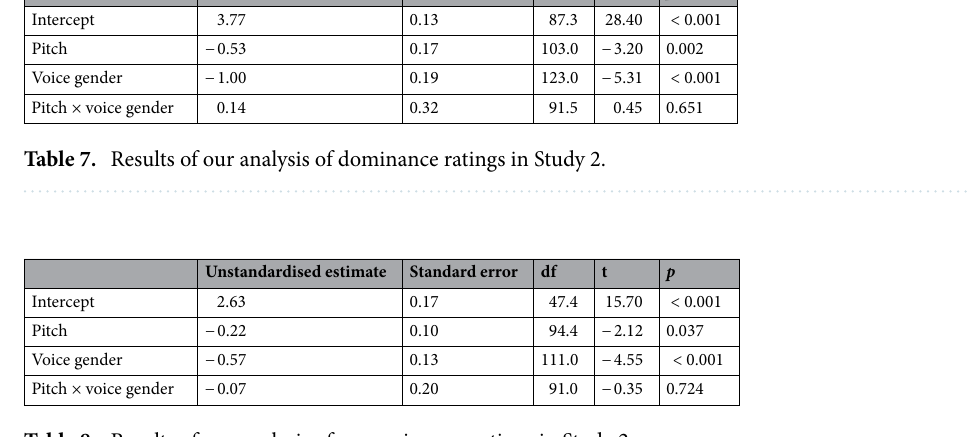
Unstandardised estimate Standard error df